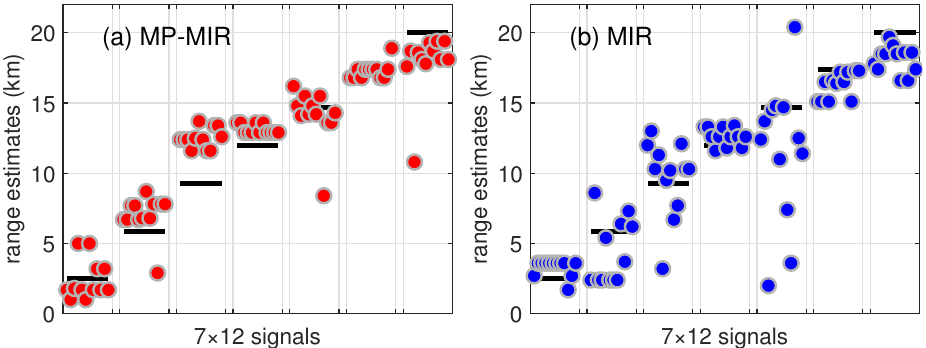
Figure 9. Ranging results of all 7 × 12 = 84 signals. Black horizontal lines represent the true ranges.